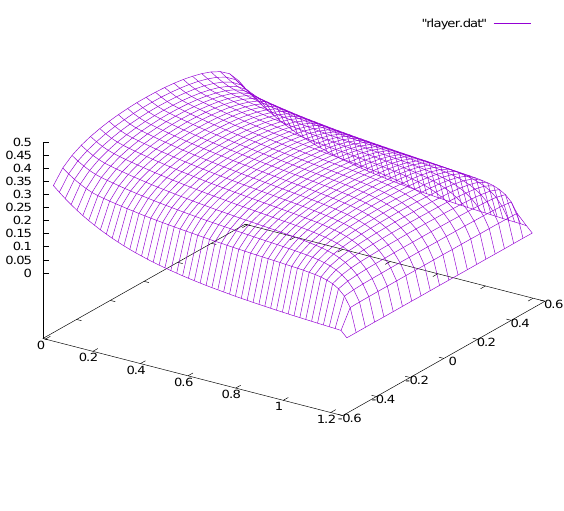
Figure 8: The vertical axis gives the thickness h ( x , y ) of the water layer in µ m. In the horizontal direction the (longer) x coordinate is measured in cm and the y coordinated in